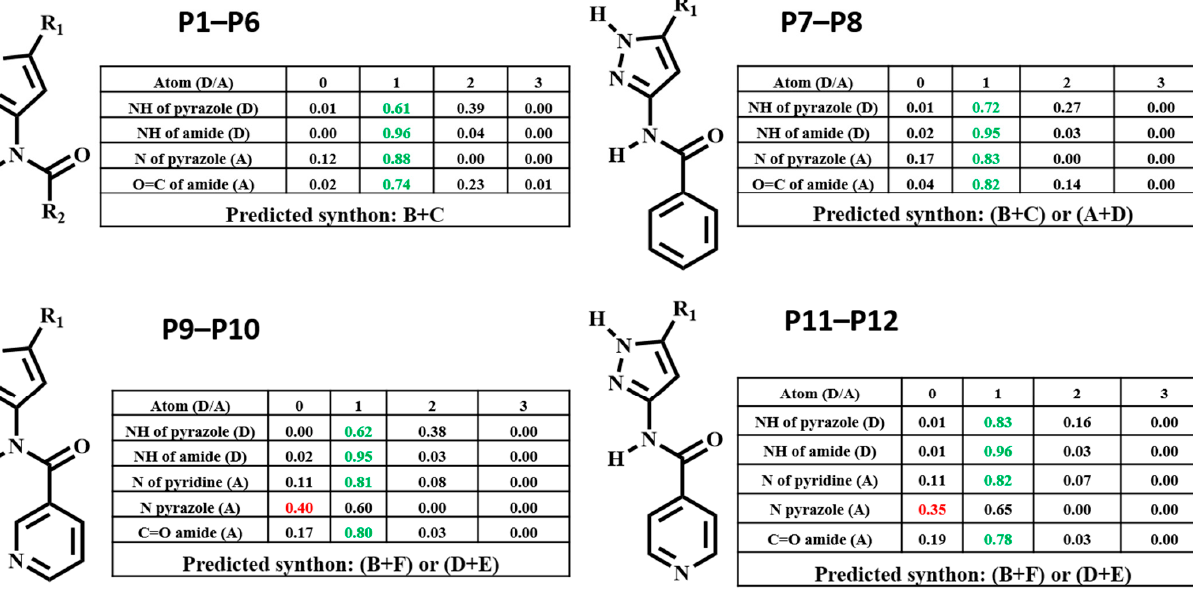
Figure 3. Predicted hydrogen-bond coordination P1 – P12 (D: hydrogen-bond donor, A: hydrogen-bond acceptor; green: optimal interactions, red: sub-optimal